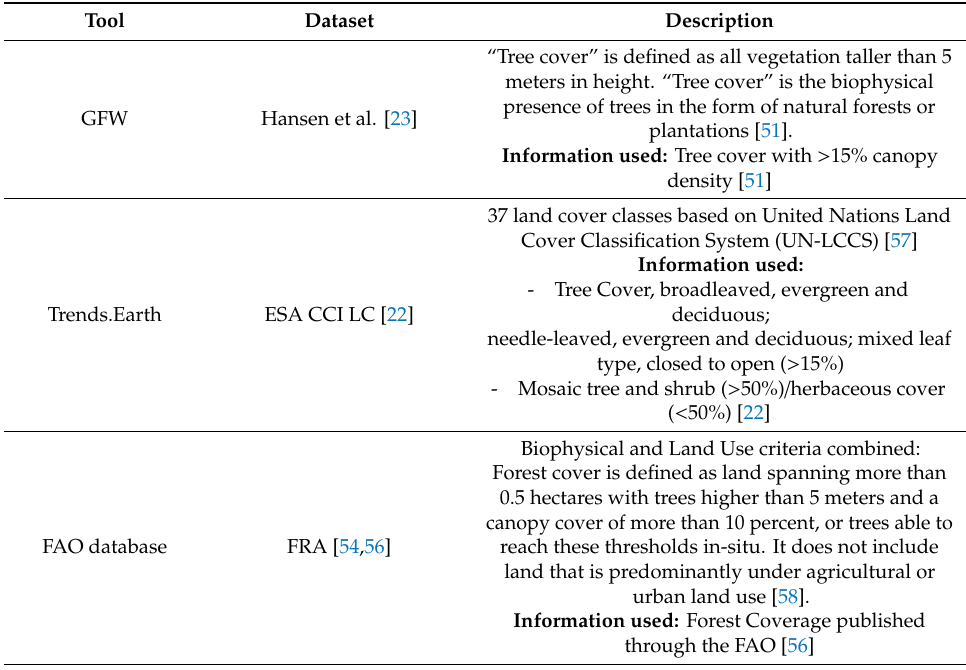
Table 3. Tools and EO data sources for the evaluation of SDG Indicator 15.1.1 (Forest Coverage).